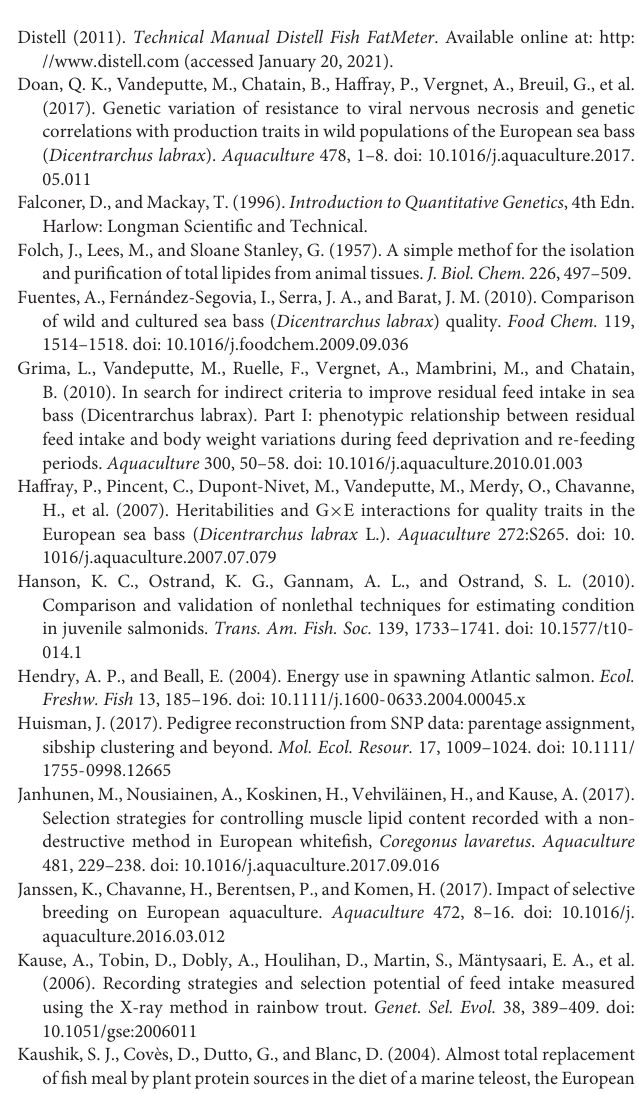
Supplementary Figure 1 | Difference between Lipid True and Lipid DSAve plotted against body weight. A linear regression is given as the solid black line with the 95% confidence interval is gray shading. Round points denote 2016 cohort and triangle point are the 2017